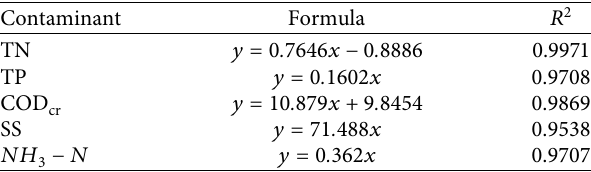
Table 1: Calculation formula for five pollutants.